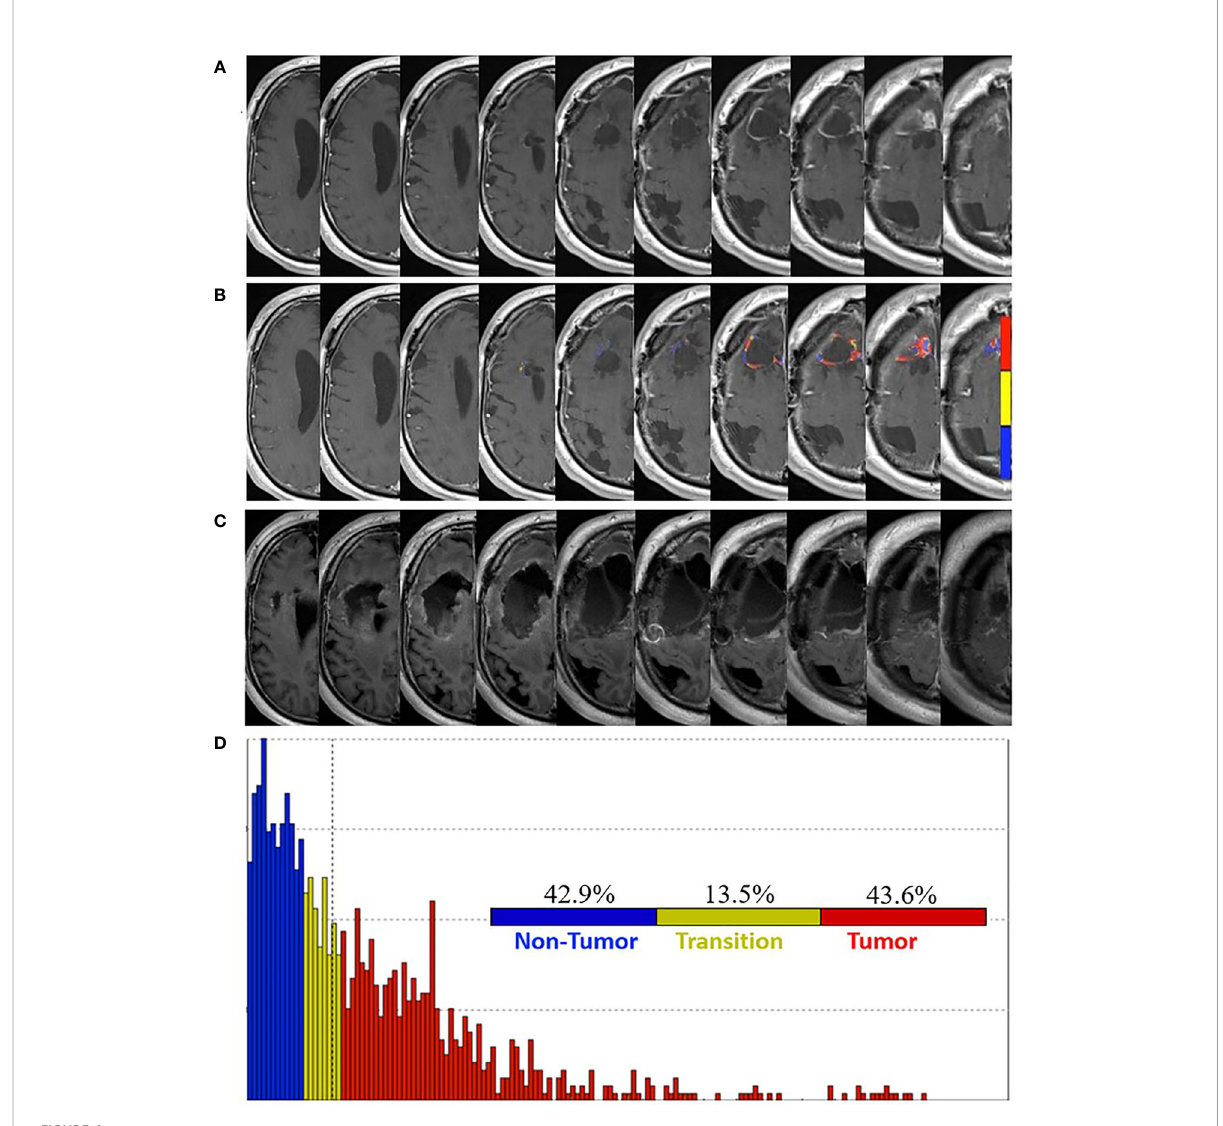
FIGURE 4 Pre- and post-surgery MRI. (A) Postcontrast T1-weighted MRI obtained 20 weeks post-pLDR and 10 weeks before redo-surgery. (B) Corresponding maps of FTB superimposed on the postcontrast T1-weighted MRI images. The FTB maps show areas of active tumor (red), treatment effect (blue), and transitional zone (yellow). (C) Immediate post-operative postcontrast T1-weighted MRI with FLAIR demonstrating extent of resection, which encompasses regions of tumor identi fi ed in the FTB maps. (D) Distribution of T1-weighted enhancement volume based on vascularization as measured by FTB